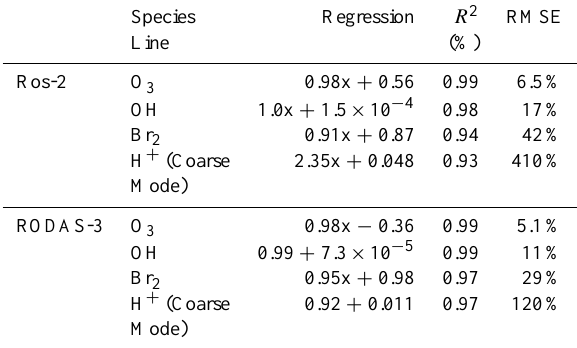
Table 1. Comparison of one-month benchmark simulations of the coupled modal-CAM/MECCA system for Ros-2 and RODAS-3 solvers versus Ros-3.